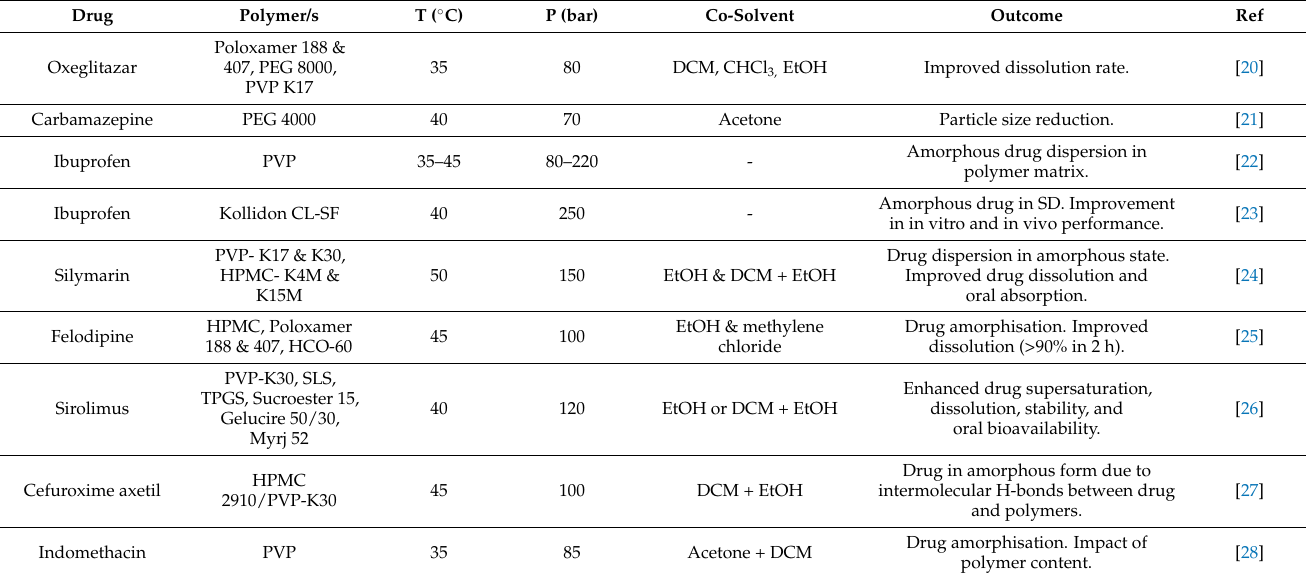
Table 1. Examples of solid dispersions prepared via scCO 2 processing of drugs and